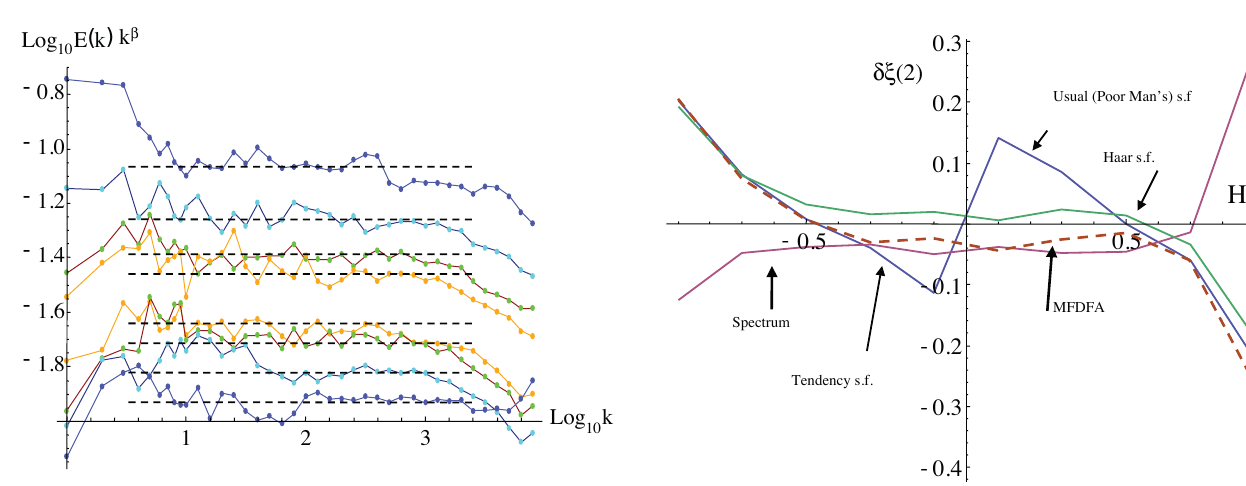
Fig. 6. This shows the regression estimates of the compensated exponents for the spectra δξ (2) = ξ (2) numerics − ξ (2) theory (red; perfect methods give δξ (2) = 0), Haar structure function ( q = 2; green), quadratic, q = 2 MFDFA (dashed), the usual difference (poor man’s) structure function ( q = 2, blue, for H > 0), and the tendency structure function ( q = 2, same line, blue for H < 0).